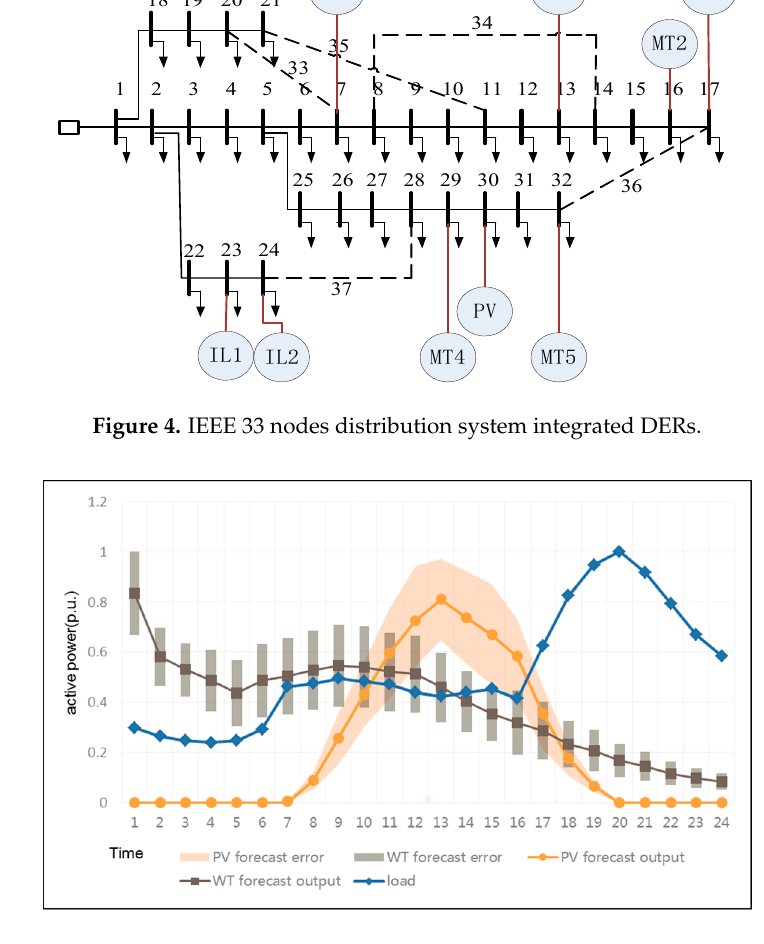
Figure 5. The practical operating data.